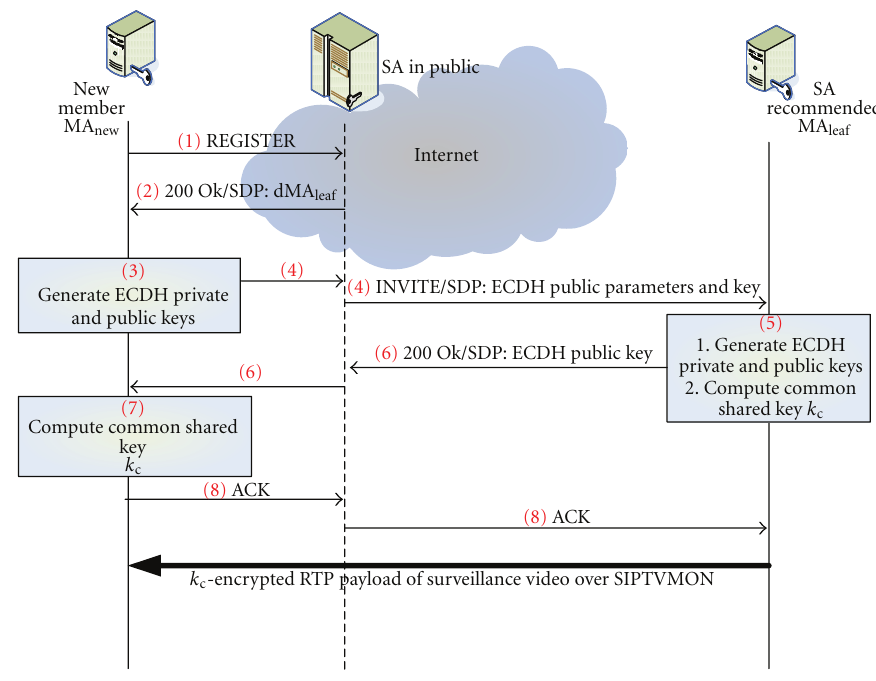
Figure 5: SIPTVMON’s join procedures for a new MA (i.e., MA new ).